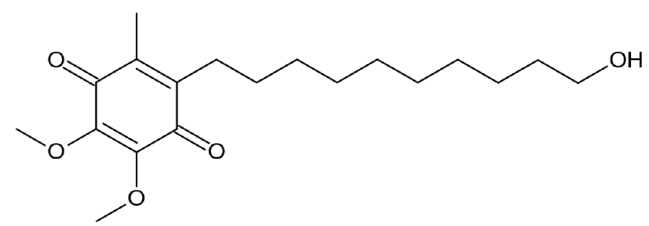
Figure 1. Chemical structure of 2,3-dimethoxy-5-methyl-6-(10-idroxydecyl)-1,4-benzoquinone (IDE).